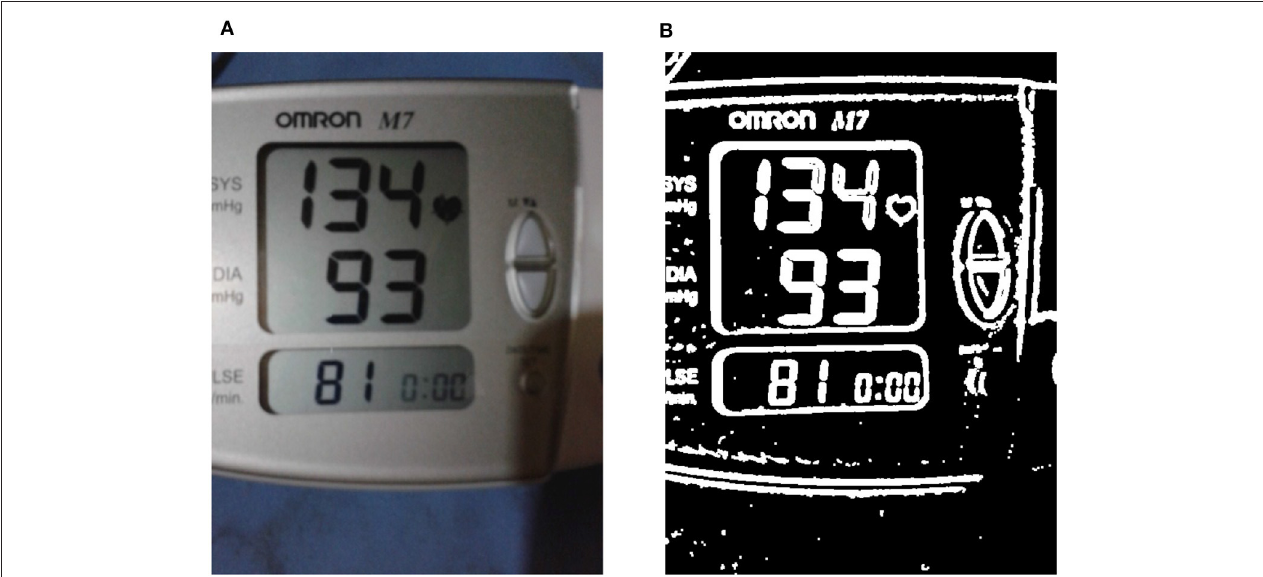
FIGURE 6 | Liquid crystal display (LCD) frame localization. (A) All possible contours on enhanced image are shown; (B) the localized region of interest obtained using LCD localization are shown (see section 3.2.2).